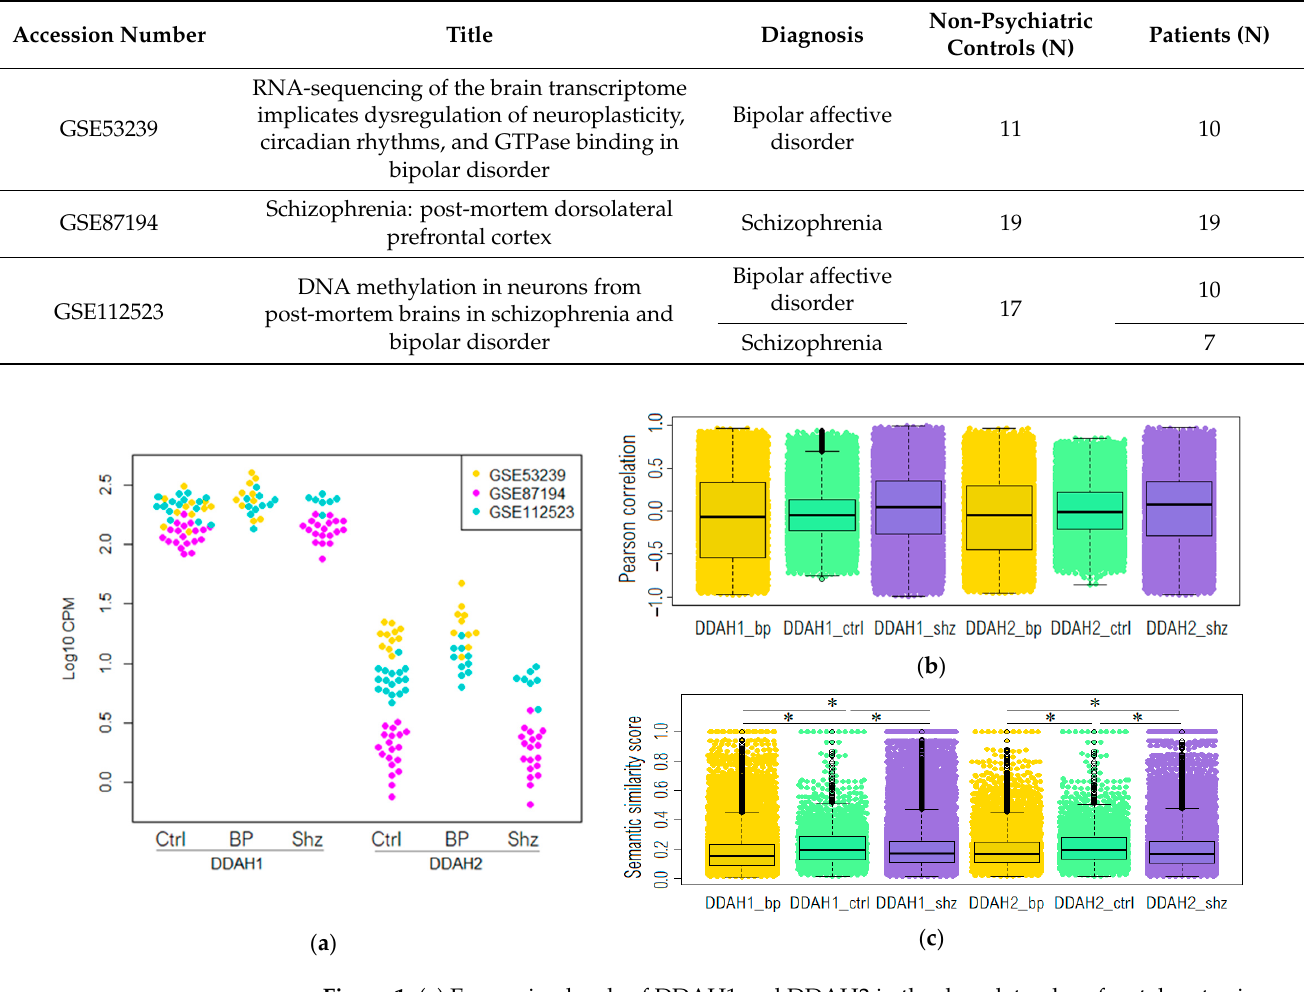
Figure 1. ( a ) Expression levels of DDAH1 and DDAH2 in the dorsolateral prefrontal cortex in non- psychiatric controls (Ctrl) and patients with bipolar affective disorder (BP) or schizophrenia (Shz) presented in three datasets: GSE53239 (yellow), GSE87194 (violet) and GSE112523 (blue). Beeswarm plot representing the distribution of correlation coefficients between DAAH1 or DAAH2 to all other genes expression levels in Brodmann area 46 in all groups ( b ) and the distribution of semantic similarity scores between the genes co-expressed (r > 0.8, p > 0.05) with DDAH1 or DDAH2 in all groups ( c ). * Games–Howell post hoc test p >